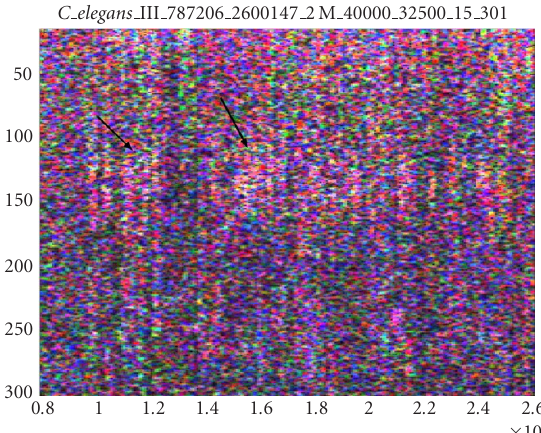
Figure 8: Spectrogram showing antagonism between 10+-base and 3-base periodicities in C. elegans chromosome III (300 Kbp). The 10+-base periodicity is at the top of the figure while the 3-base pe- riodicity is shown at the very bottom.